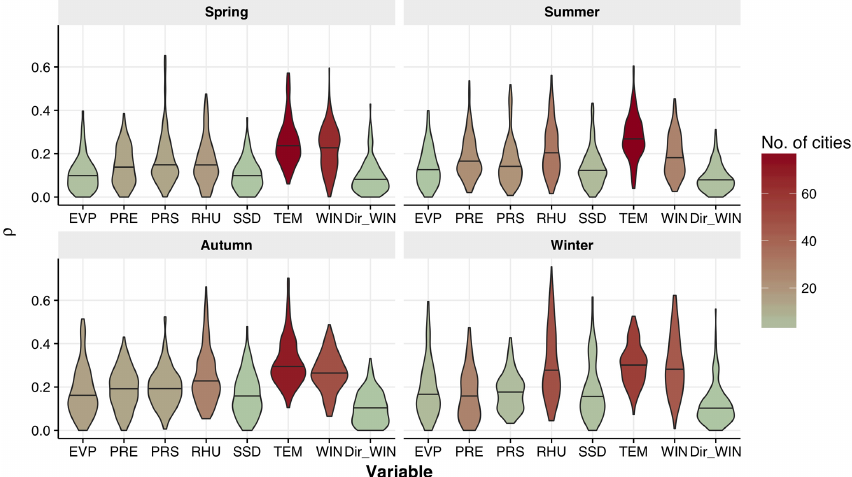
Figure 4. Violin plots of the influence of eight different meteorological factors on local PM 2 . 5 concentrations in 188 cities across China. No. of cities: the number of cities with this factor as the dominant meteorological factor (its ρ value is the largest amongst eight factors) on local PM 2 . 5 concentrations. The shape of the violin bars indicated the frequency distribution of ρ value for 188